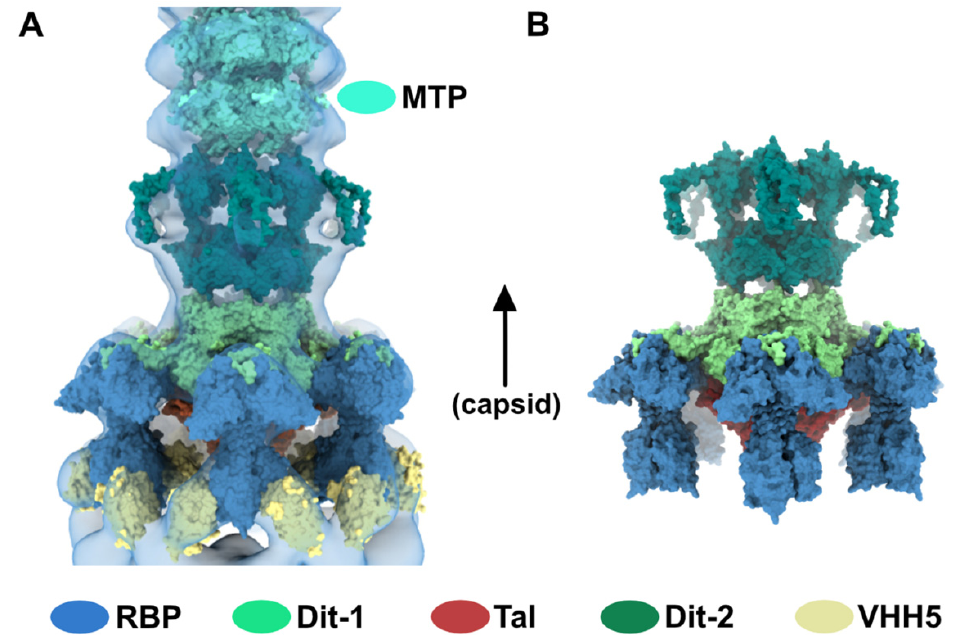
Figure 5. Topological model of the activated baseplate in p2 virions. ( A ) Surface representation of the baseplate components (PDB ID 2X53) and VHH5 (PDB ID 2BSE) fitted in the 3D reconstruction of